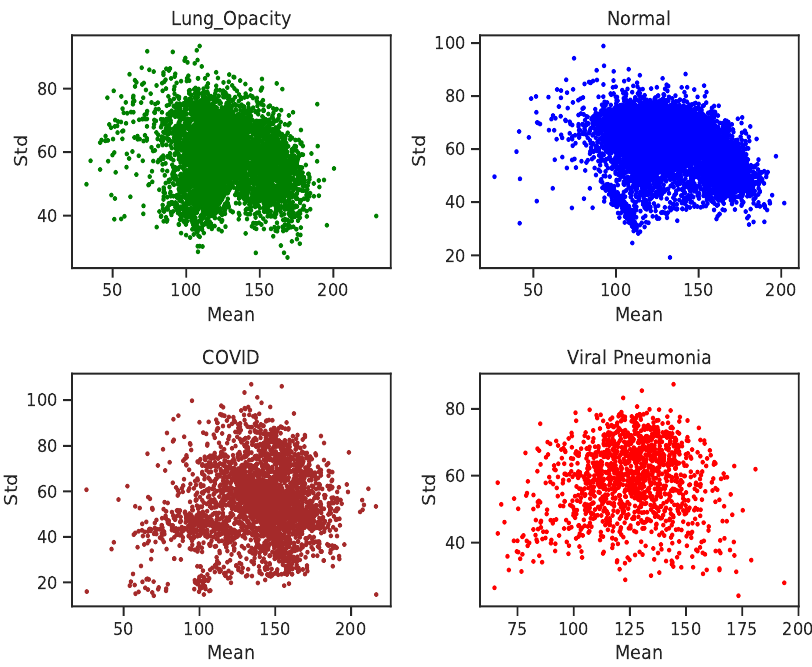
Figure 8. Individual class distributions for COVID-19 (bottom-right) to Healthy (top-left). Normal (healthy) and Lung Opacity images have a similar cluster formation and pixel intensity